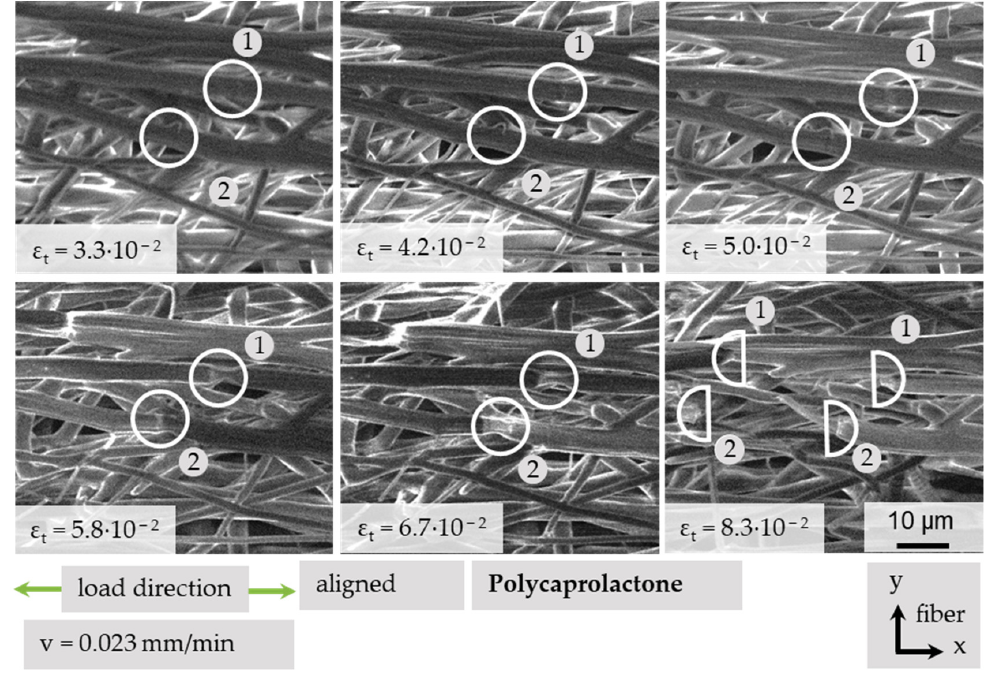
Figure 13. Local necking and fracture of single PCL fibers under tensile load.